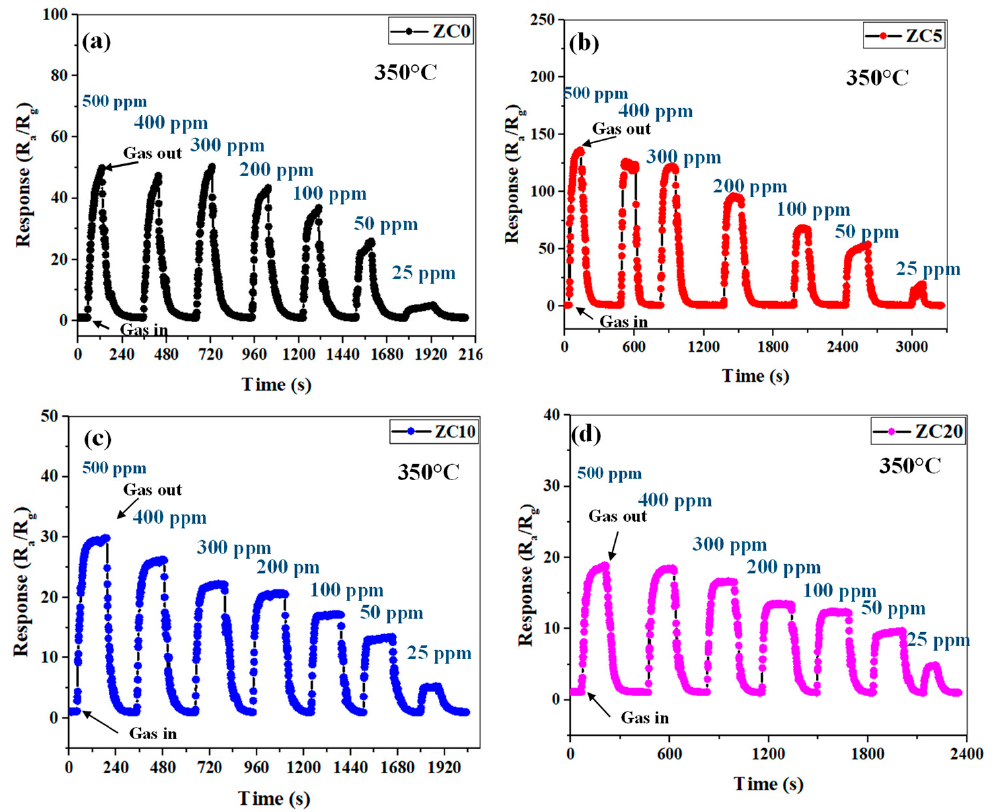
Figure 9. Dynamic response of ( a ) ZC0, ( b ) ZC5, ( c ) ZC10, and ( d ) ZC20 gas sensors to various concentrations of ethanol at 350 ◦